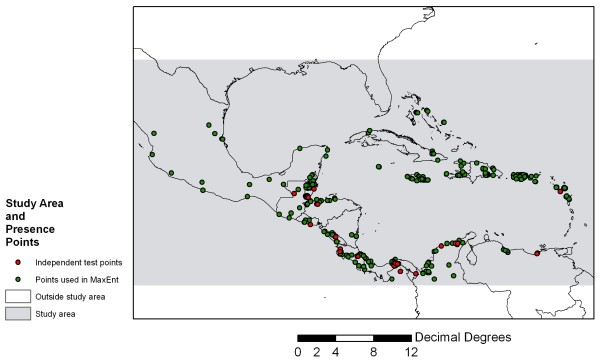
Distribution ofAn. albimanusrecords used to parameterize and test MaxEnt projections within the study area.